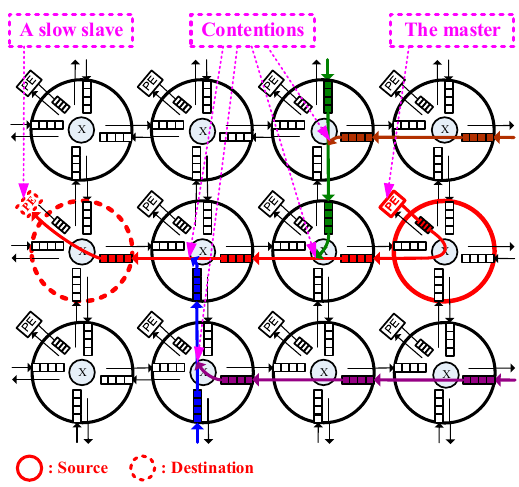
Figure 1. Congestion tree caused by contentions.